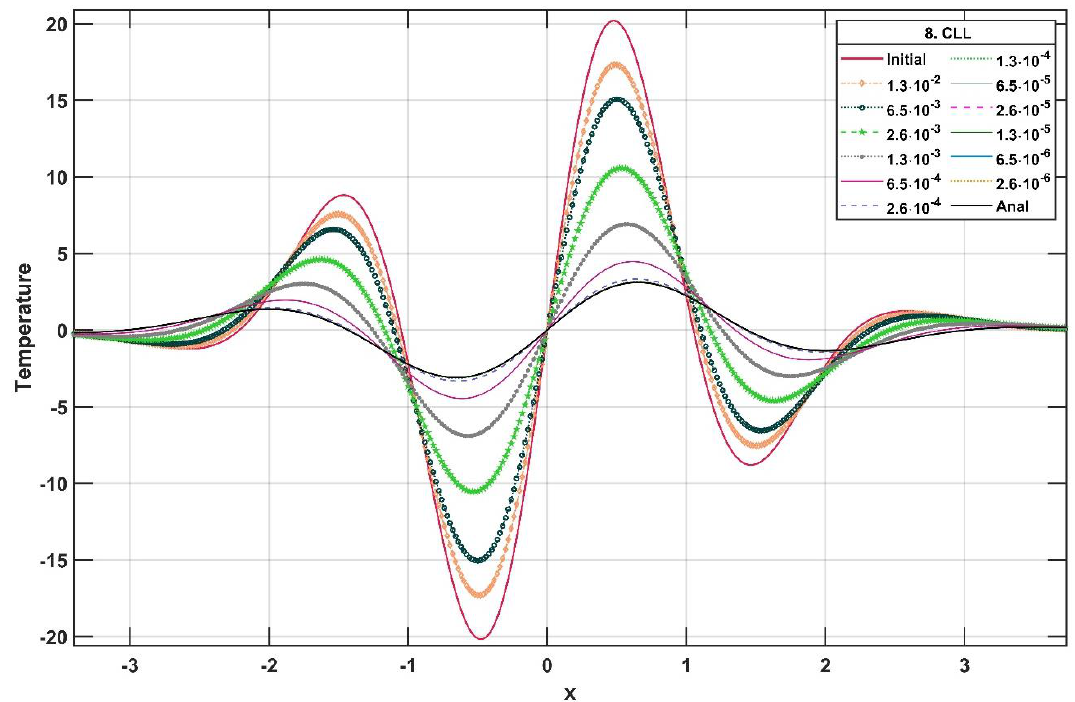
Figure 5. The numerically calculated temperatures u for the three-stage CLL method as a function of the space variable x for different time step sizes in Experiment 1. The red and the black solid lines are for the initial and the analytically calculated temperatures, respectively.